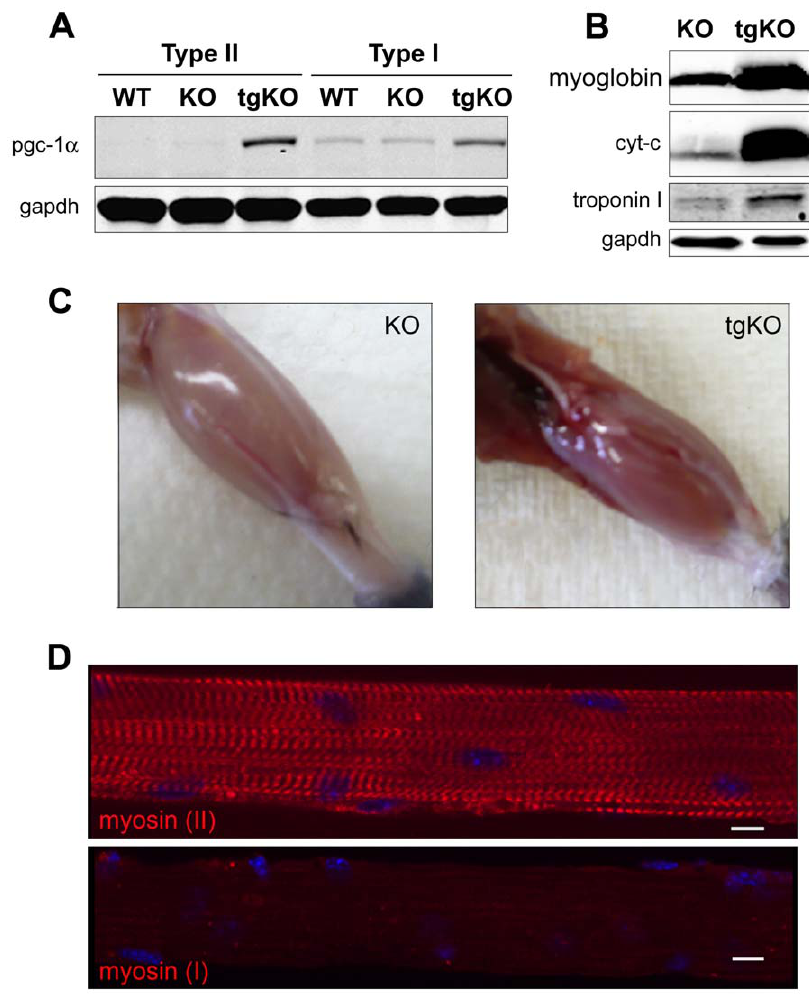
Figure 1. Characterization of muscle-specific tgKO mice. ( a ) Western blotting of protein lysates from white gastrocnemius (type II) and soleus muscle (type I) derived from WT, KO, and tgKO mice with PGC-1 a antibody. The transgene is expressed in both type I and type II fibers. Muscle samples were taken from 3–6 month-old mice. Two WT, five KO and five tgKO mice were analyzed. ( b ) Western blot analyses of different proteins in gastrocnemius muscle of KO and tgKO mice. GAPDH was used as loading control. ( c ) Appearance of gastrocnemius muscle fibers in KO and tgKO mice. ( d ) Single fibers were stained for the fast (myosin II) and slow (myosin I) isoforms of myosin heavy chain. The fibers were isolated from psoas muscle (which normally contains mostly type II fibers) of a tgKO mouse. Bar: 10 m